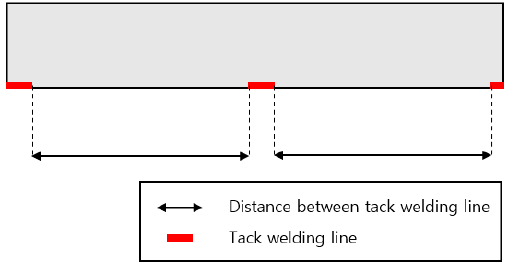
Figure 6. Tack welding distance and length.